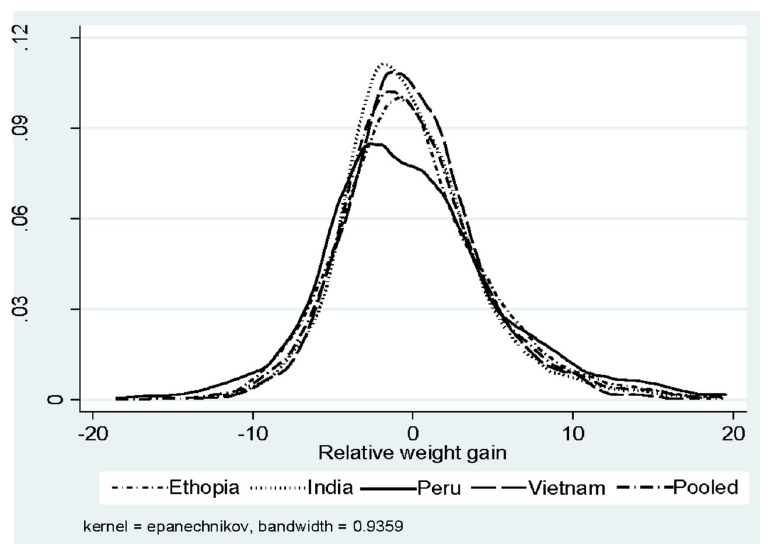
Fig 2. Kernel density of the relative weight gain between 2002 & 2009, Ethiopia, India, Peru, Vietnam, and the pooled